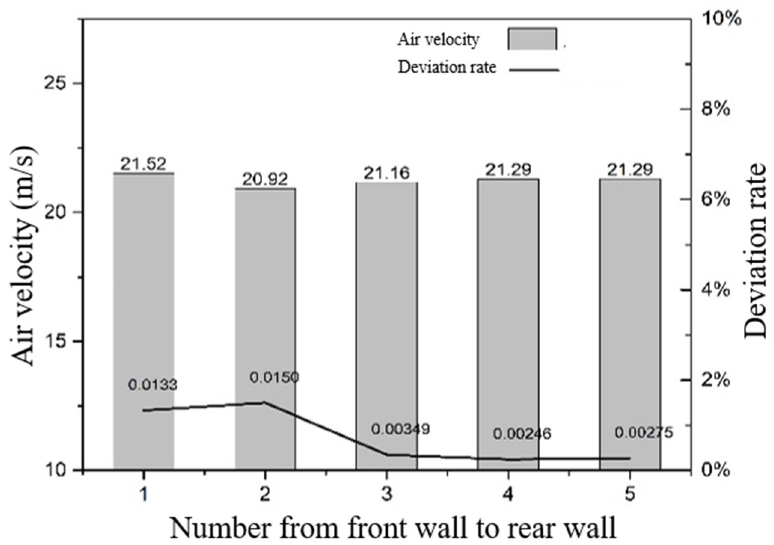
Figure 11. The calculated value of internal side upper secondary air exit velocity.